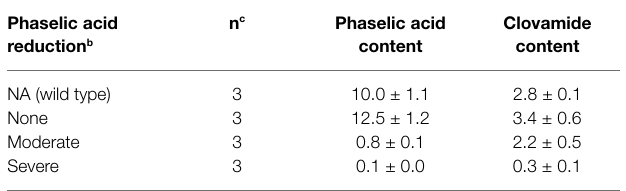
TABLE 3 | trans -Phaselic acid and trans -clovamide content a in mature leaves for groups of plants transformed with an HMT RNAi construct.